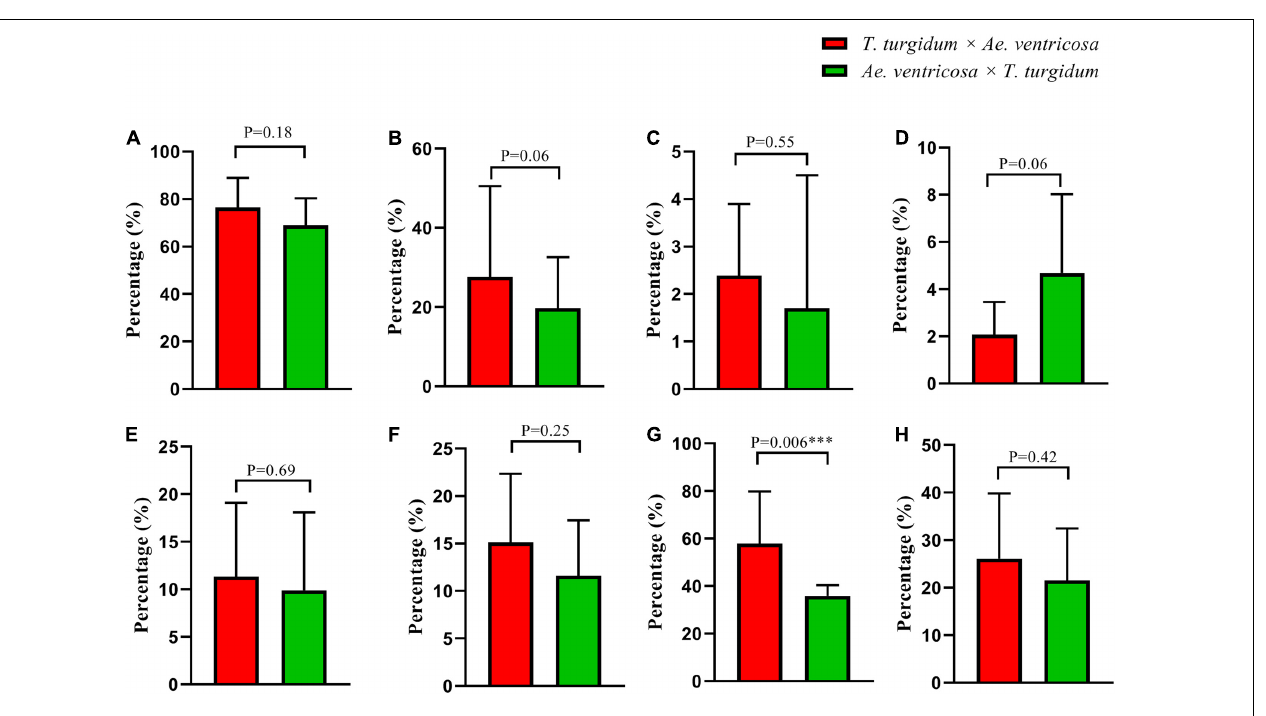
FIGURE 10 | Chromosomal behavior biases in reciprocal crosses. (A) Frequencies of aneuploids; (B) Frequencies of chromosome loss; (C) Frequencies of chromosome gain; (D) Frequencies of chromosomal structural variation; (E–H) Frequencies of chromosome loss in A, B, D v , and N v